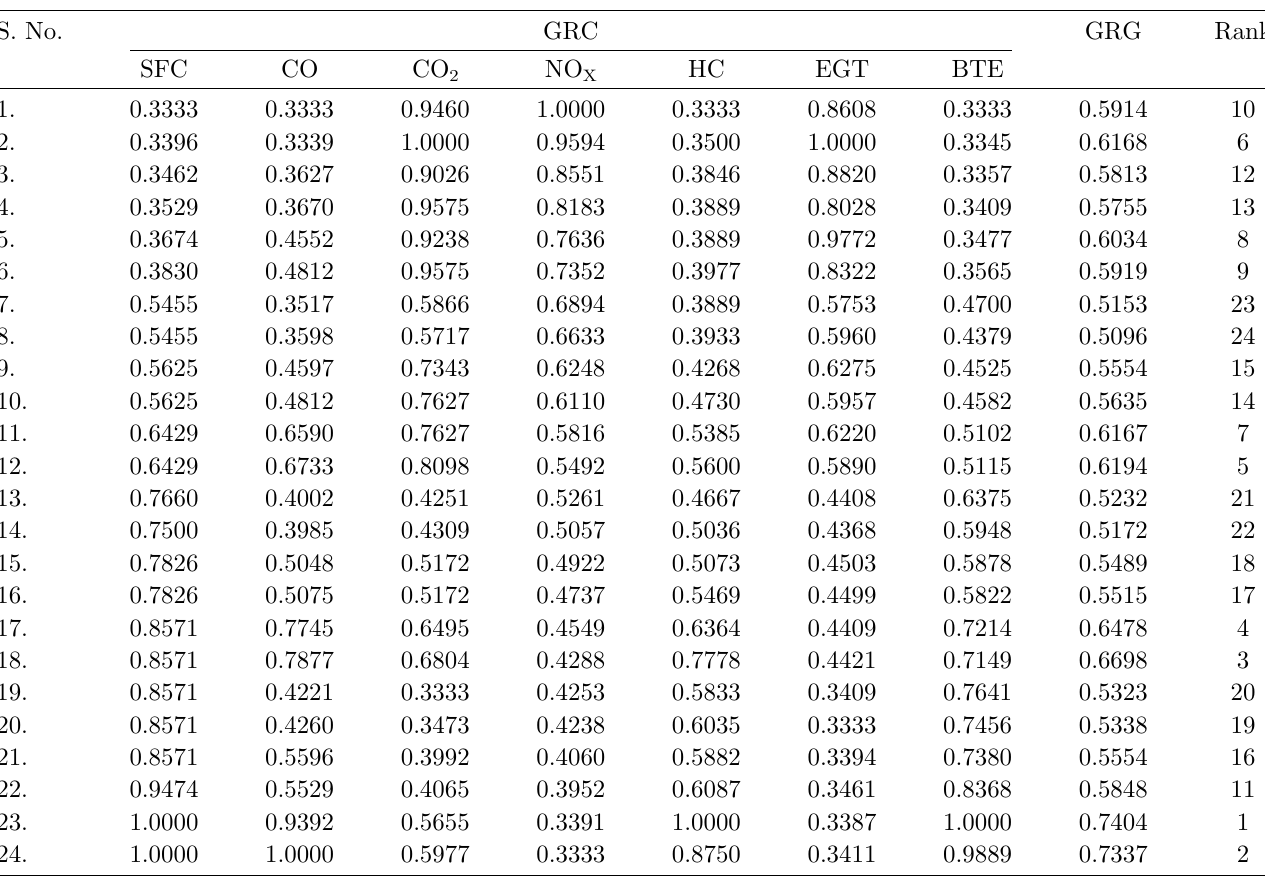
Table 5. GRC and GRG values for the trials. S. No.